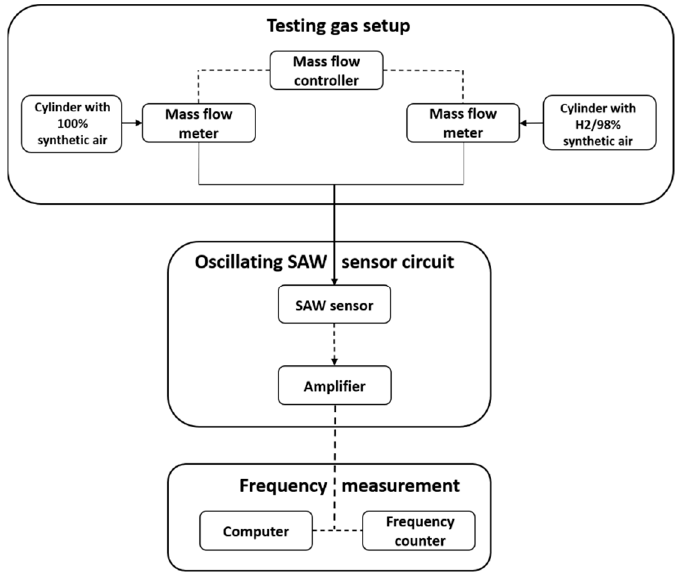
Figure 1. Experimental setup for SAW sensors’ frequency shift measurements for hydrogen detec-